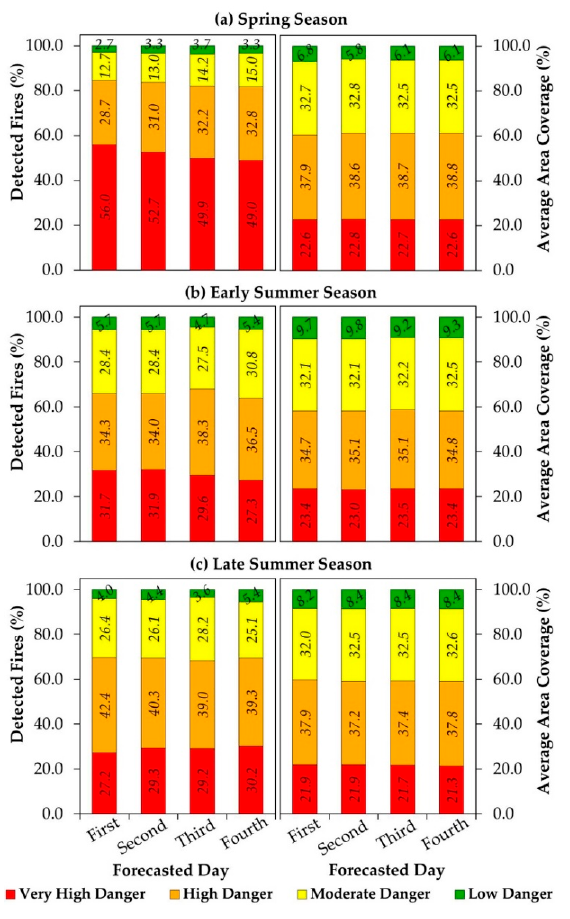
Figure 5. The seasonal validation of the RS-based four-day scale FFDFS model against the historical forest fire occurrences during the 2015–2017 period that included ( a ) spring season, ( b ) early summer season, and ( c ) late summer season.